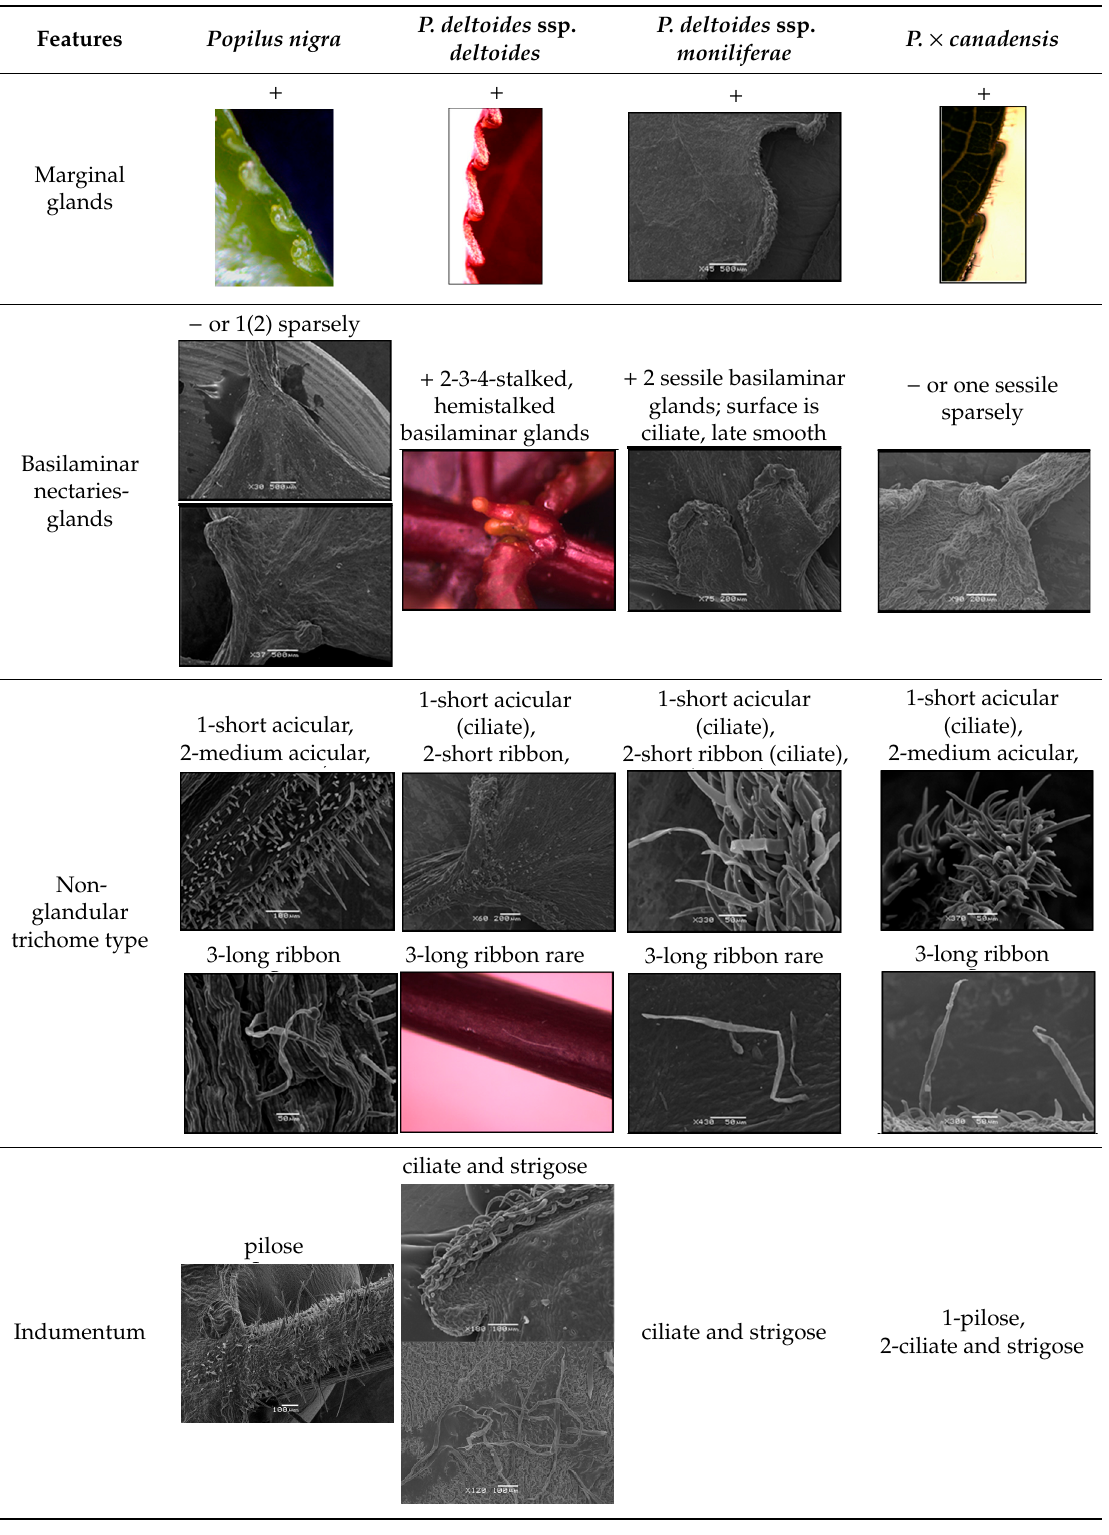
Table 1. The major trichomes diagnostic features of the Aigeiros section poplars. Features